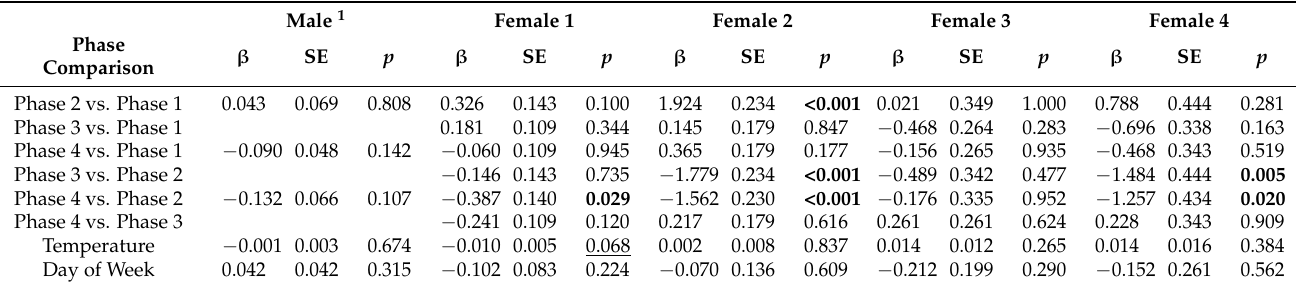
Table 6. Pairwise comparisons of glucocorticoids by phase as well as associations with temperature and day of the week (weekday vs. weekend) for each banteng.